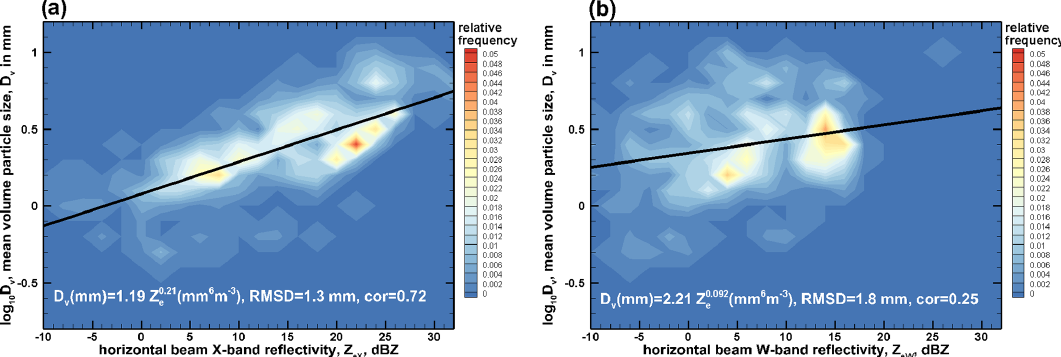
Figure 7. Frequency scatter plots of mean volume PSD size, D v , versus (a) X-band and (b) W-band reflectivity observed at horizontal beam pointing. Best-fit power-law approximations and corresponding RMSD values are also shown.